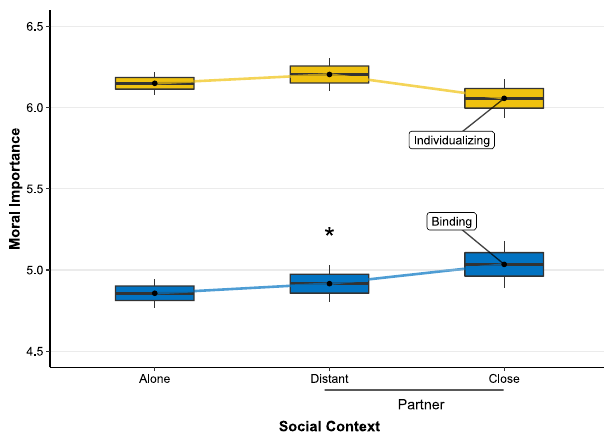
Fig. 3 The association between social context (alone, distant partner, close partner) and moral importance according to value type. Binding values were rated more important when participants were with a partner they rated as close than when they were alone. Box centers re fl ect group means; edges SEM; whiskers 95% CI ( n = 390). Source data are provided as a Source data fi le. *Difference between means signi fi cant, F (2, 340) = 3.69, p =